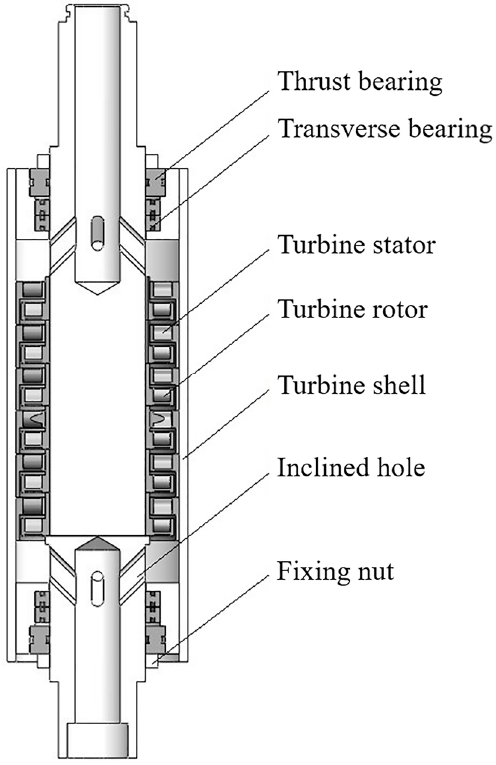
Figure 2. Cross-sectional view of DFDRs main functioning parts.